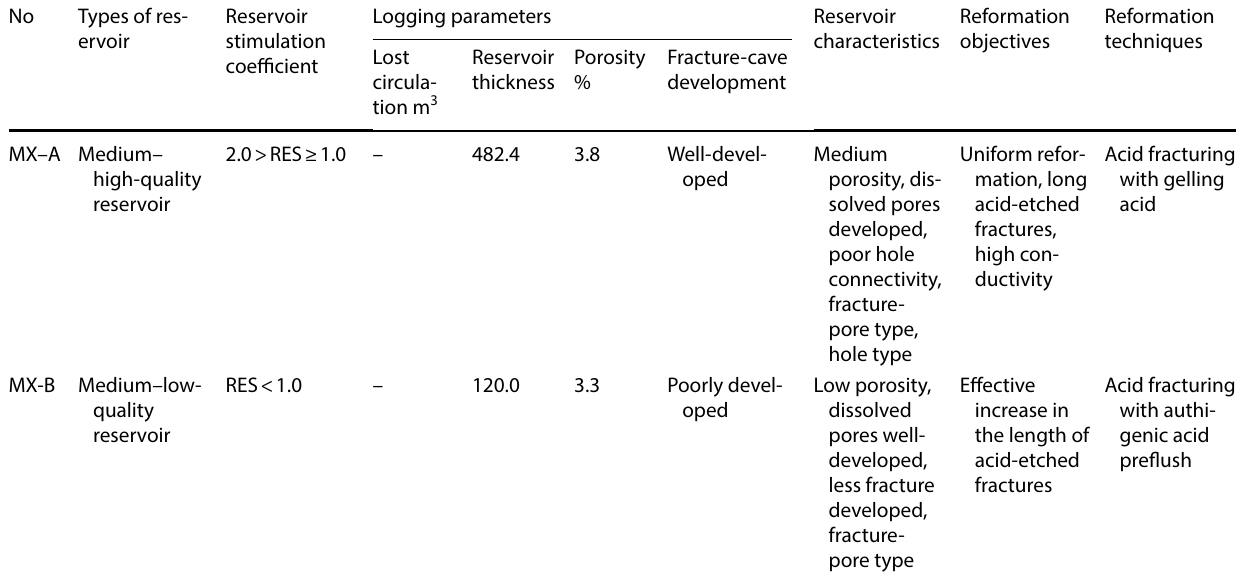
Table 5 Implementation of reservoir stimulation process for highly deviated wells No